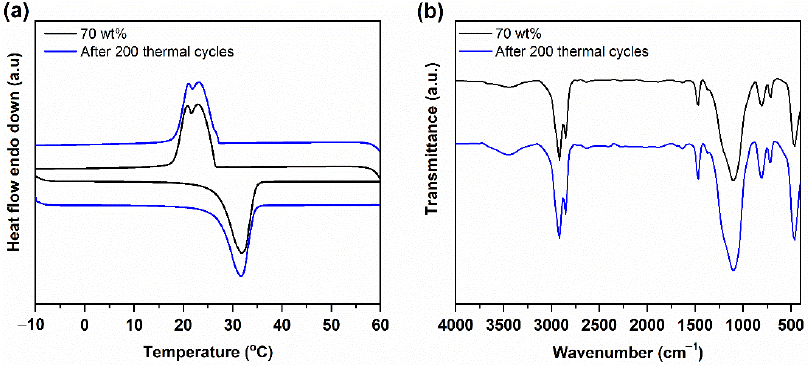
Figure 7. ( a ) DSC curves and ( b ) FT-IR spectra of the 70 wt% n-octadecane/FS PCC before and after 200 thermal cycles.